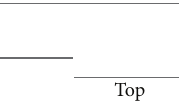
Figure 1: Cutting process of whole jute